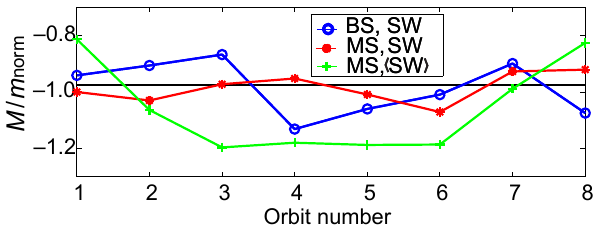
Figure 2. Estimated dipole moments using THC data at orbits from 24.8, 25.8, 27.8, 29.8, 31.8, 2.9, 4.9, and 6.9, labeled by orbit num- bers 1 to 8. The dipole moment was estimated by THC bow shock observations together with pre-shock solar wind conditions (blue), by THC magnetosheath data using the time-dependent OMNI so- lar wind observations, and by THC magnetosheath data with aver- age solar wind conditions (green). The z component of the Earth’s dipole moment is depicted as a black line. Dipole moments are nor- malized to m norm = 8 . 0 × 10 15 Tm 3 .